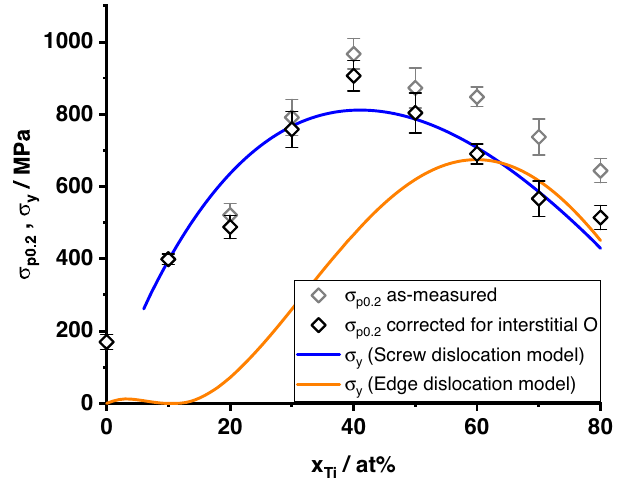
Fig. 5 Comparison of offset yield strength to models. 0.2% Offset yield strength σ p0.2 as measured (gray symbols) and corrected for interstitial O content (black symbols) according to the description in the body text. The solid lines show the predictions for the yield strength σ y according to the screw (blue) and edge dislocation model (orange). The screw dislocation model is not applicable in dilute solid